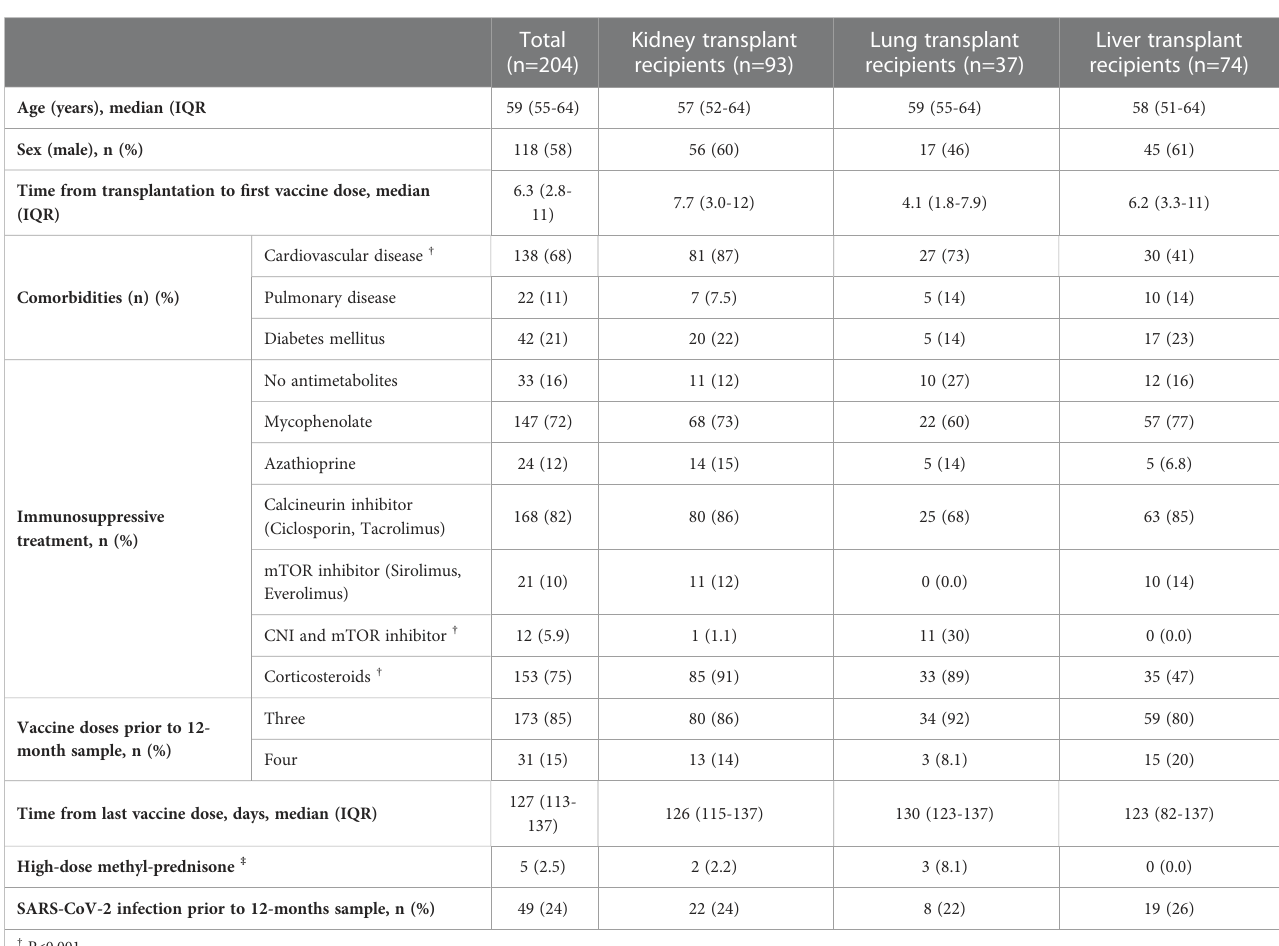
TABLE 1 Patients